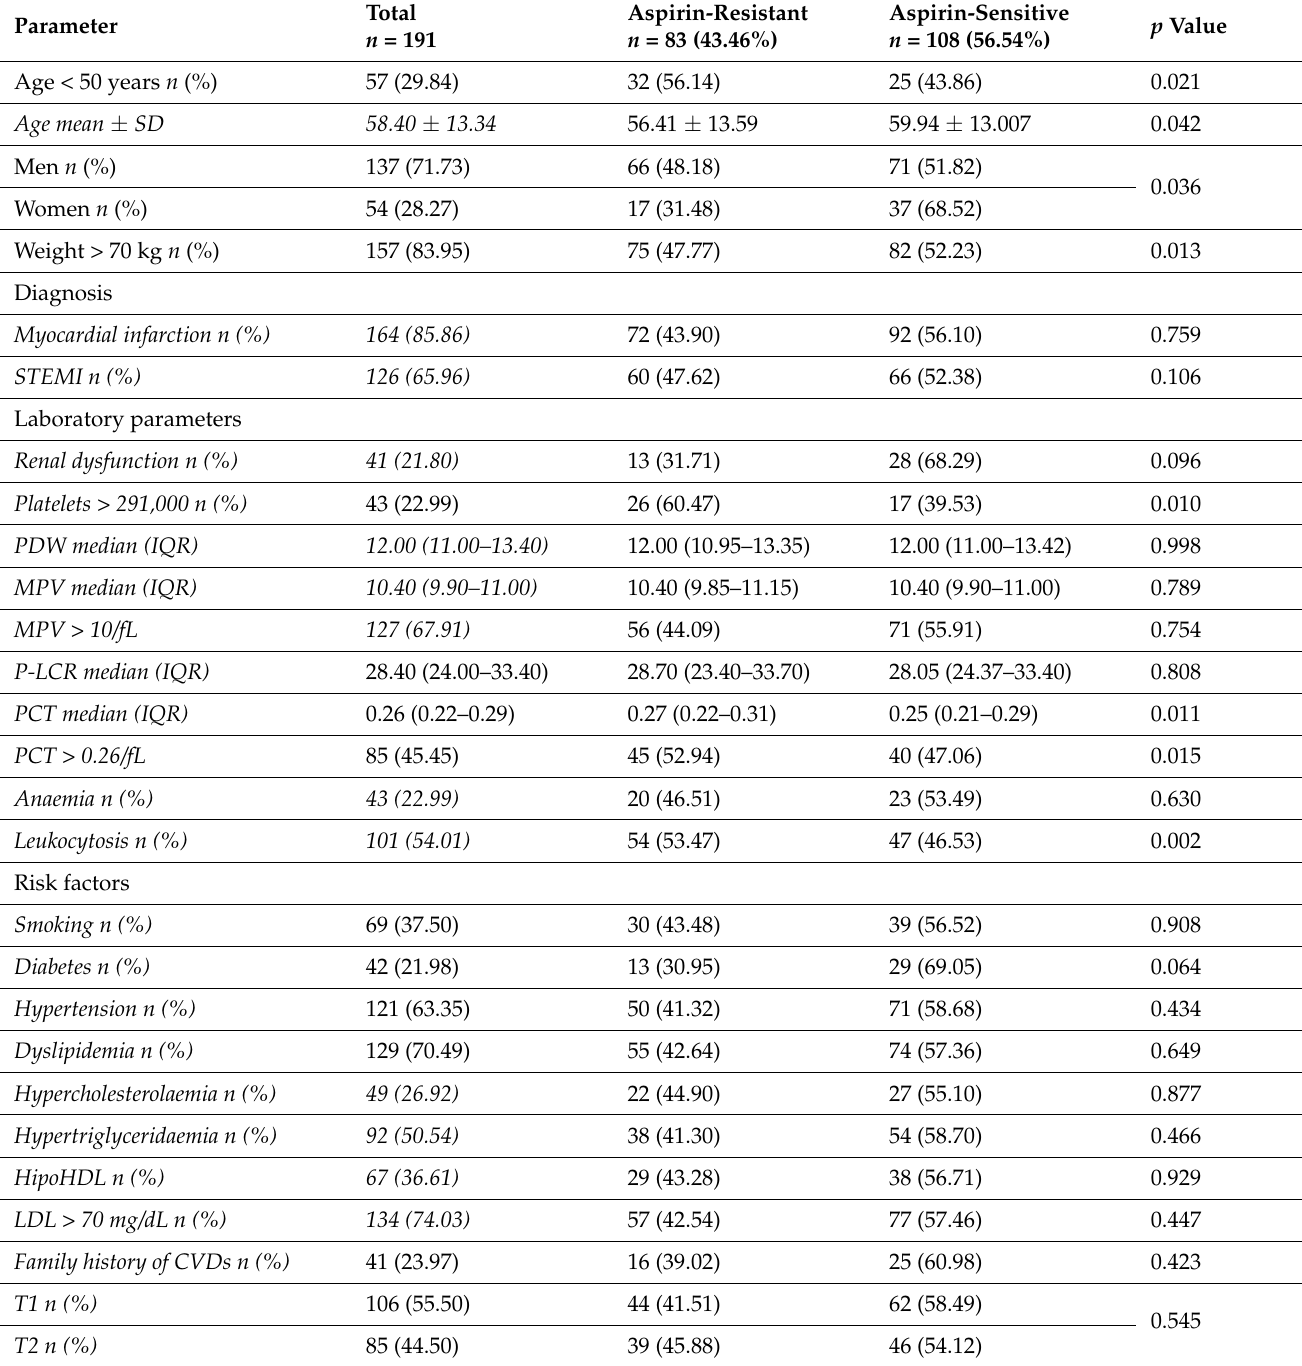
Table 2. Factors analyzed according to aspirin